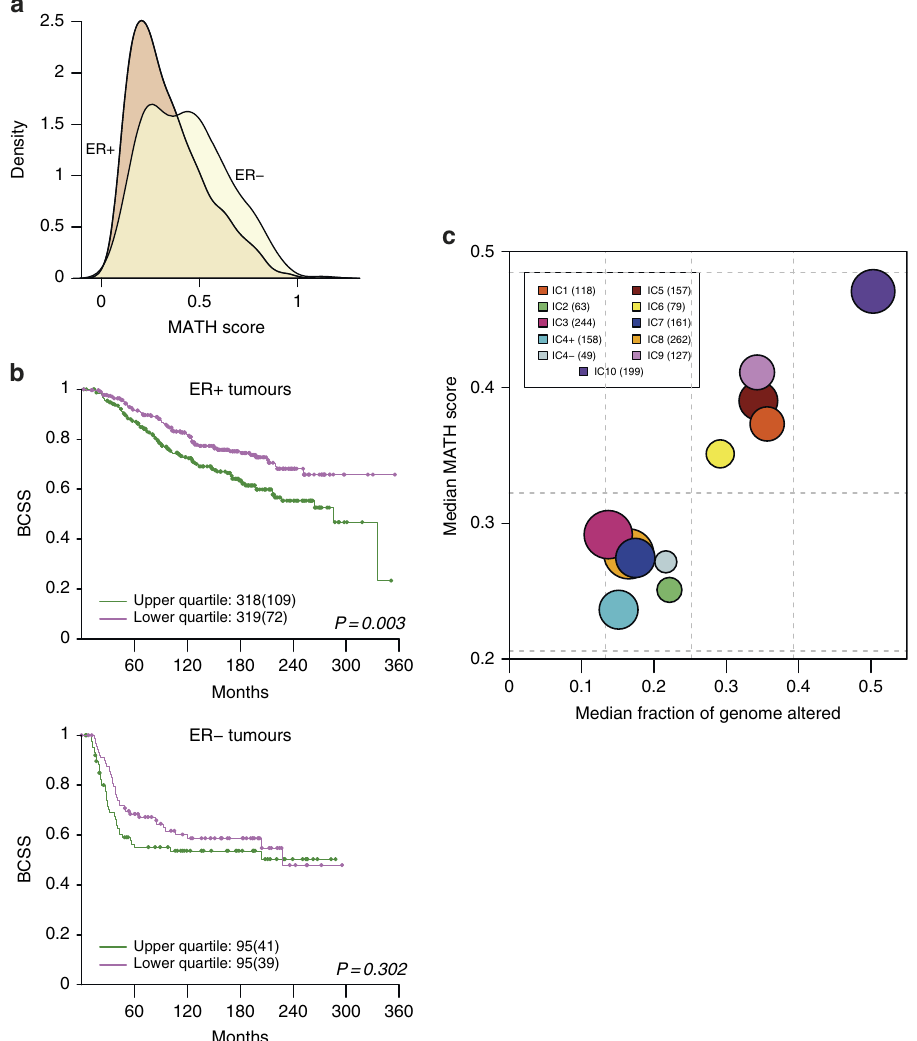
Figure 7 | Intra-tumour heterogeneity in breast cancers stratified by IntClust. ( a ) The distributions of mutant-allele tumour heterogeneity (MATH) scores are shown for ER þ and ER (cid:3) tumours. The score represents a measure of the level of intra-tumour heterogeneity, and was calculated for each tumour as described in Methods. In general, ER þ samples have lower MATH scores than ER (cid:3) samples, although there are a number of ER þ samples with higher scores. Tumours with fewer than five mutations were excluded from this analysis. ( b ) Kaplan–Meier survival curves (BCSS) are shown for tumours whose MATH scores fall in the lower or upper quartiles of the ER þ (top) and ER (cid:3) (bottom) distributions. The numbers of samples under consideration are indicated, and the numbers in brackets represent the deaths occurring in each cohort. ( c ) Bubble plot of median MATH scores and CIN scores for each IntClust. The CIN is a measure of the percentage of the genome altered by CNAs. Dashed lines depict the quartiles for both scores (vertical lines, CIN quartiles; horizontal lines, MATH score quartiles) in the cohort as a whole. The areas of the circles are proportional to number of samples in each